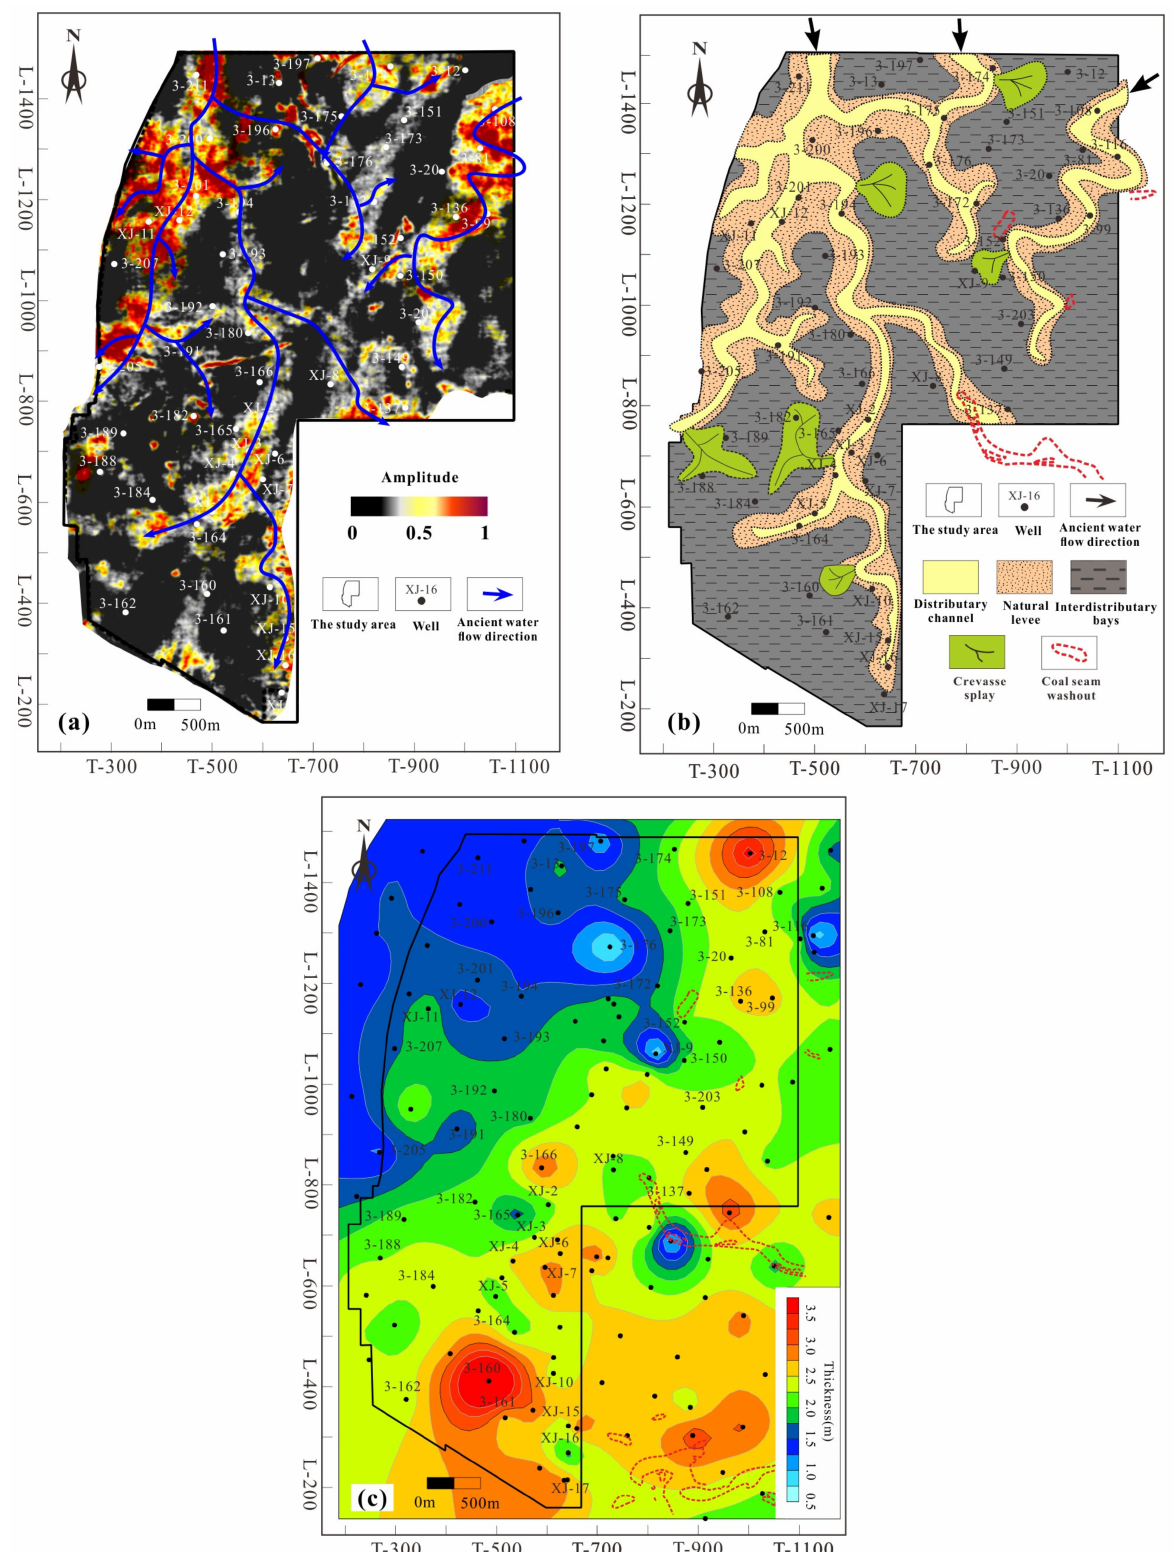
Figure 10. ( a ) SS2 sequence frequency–division amplitude fusion results; ( b ) sedimentary microfacies of the SS2 sequence; ( c ) thickness of the No. 3 coal seam obtained by Kriging